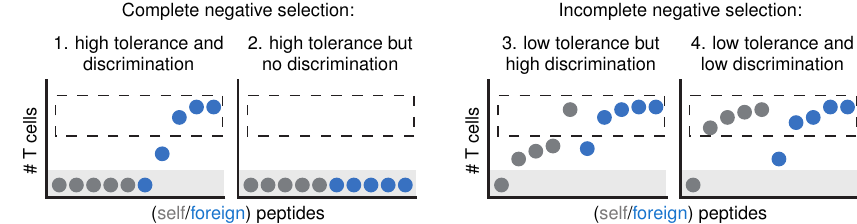
Figure 1. The relationship between tolerance and discrimination becomes more complex when negative selection is incomplete. If negative selection were “complete”, all self peptides would be presented in the thymus and all self-reactive T cells would be silenced (case 1). In other words, all self peptides would be completely tolerated (no responding T cells left, gray area), and there would be perfect self-foreign discrimination (dashed region: all peptides that are still properly recognized are foreign). The only way to have no discrimination in this scenario is if negative selection would be “too complete”, such that not only all self peptides, but also all foreign peptides are completely tolerated (case 2). If negative selection is incomplete, low tolerance can occur with either very strong (case 3), or very low discrimination (case